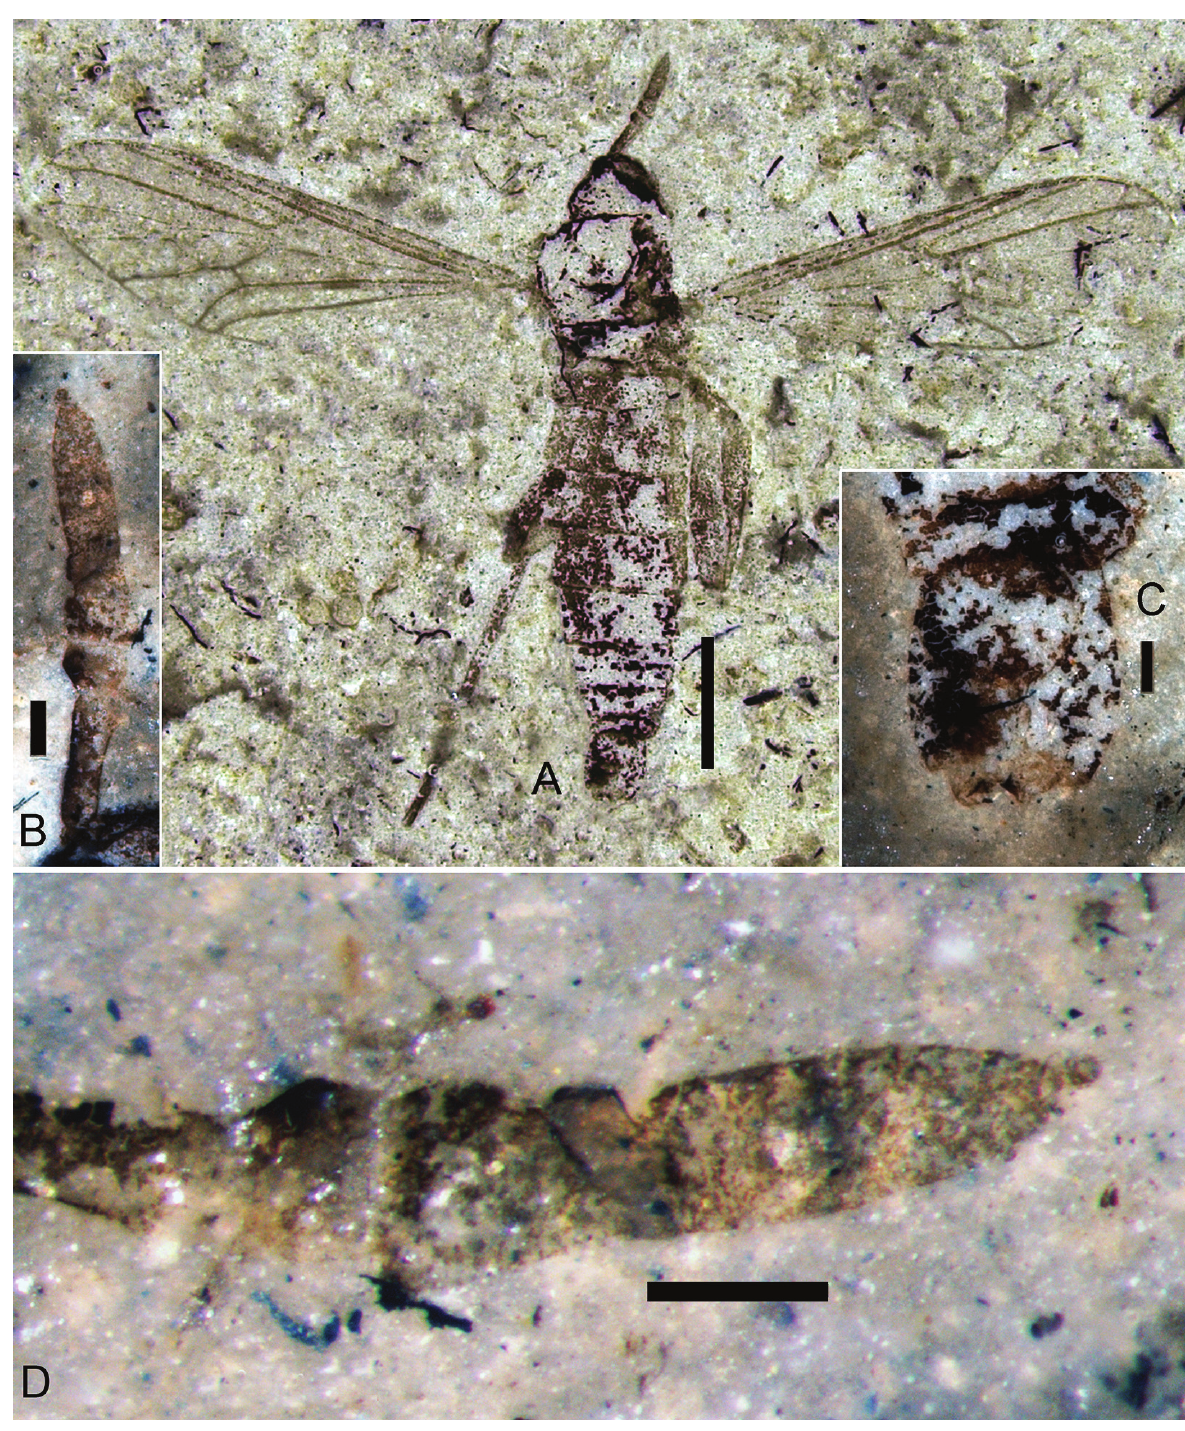
Figure 1. Flagellisargus ( Changbingisargus ) parvus subgen. et sp. n., photomicrographs, holotype NIGP DHG01701, A habitus (dorsal view), B antenna, C male genitalia, D enlarged flagellum. Scale bar 1 mm ( A ), 0.1 mm ( B, C, D